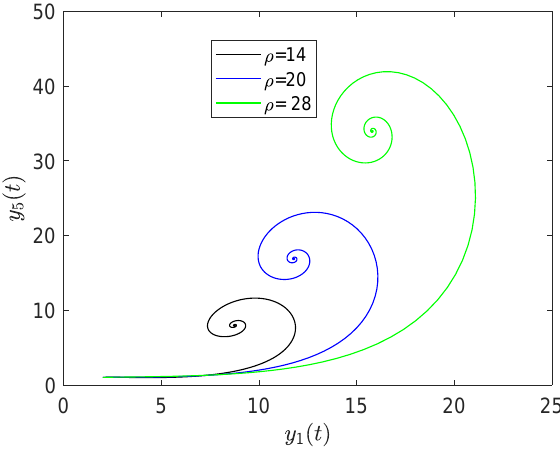
Figure 46. Phase portraits of y 1 and y 5 when varying ρ .